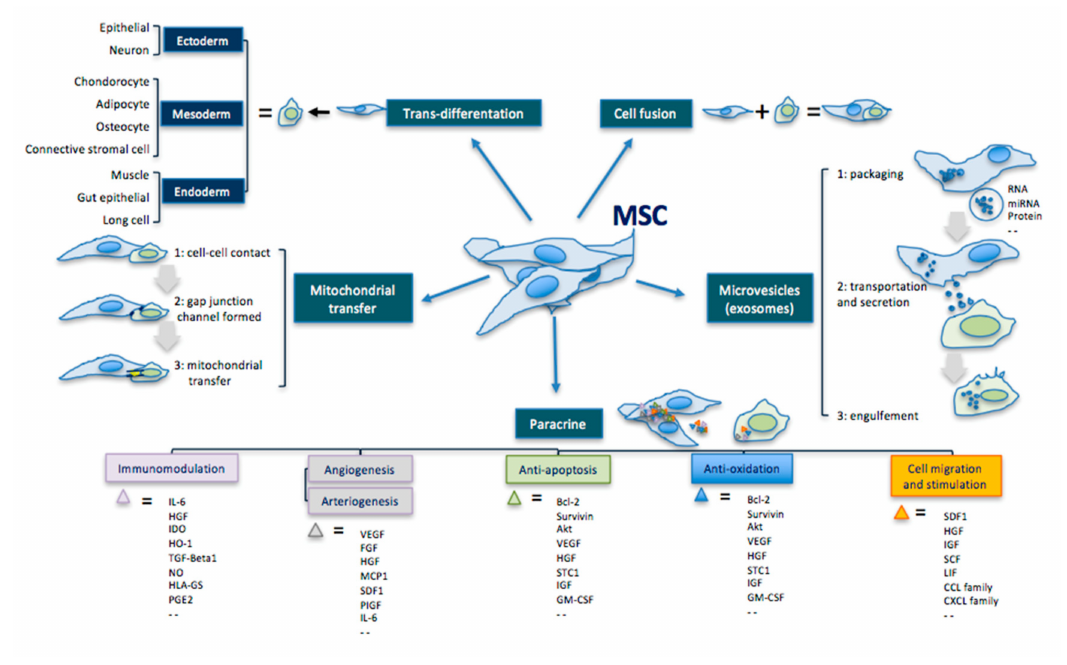
Figure 1. Principal therapeutic mechanisms of MSCs, modified by Liang